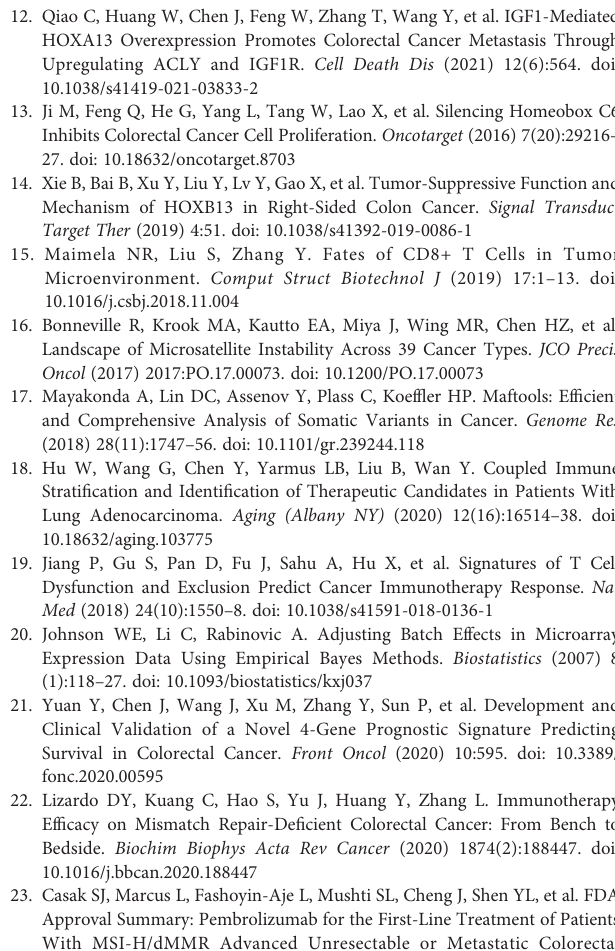
Supplementary Figure 1 | Signi fi cantly upregulated HOX family genes in CRC tissues compared to normal colon tissues, however the upregulation had no effect on OS based on TCGA samples in UALCAN database. Supplementary Figure 2 | Signi fi cantly downregulated HOX family genes in CRC tissues compared to normal colon tissues, however the downregulation had no effect on OS based on TCGA samples in UALCAN database. Supplementary Figure 3 | (A) Mutation type analysis in HOXC6 high-expression group. (B) Mutation type analysis in HOXC6 low-expression group. (C) Top 10 signi fi cantly mutated genes in HOXC6 high-expression group compared to HOXC6 low-expression group ( P <0.01). Ti: Transition; Tv: